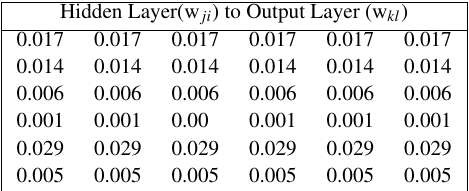
Table 3. NFRGNN with initial connection weights in fuzzy case for Telugu